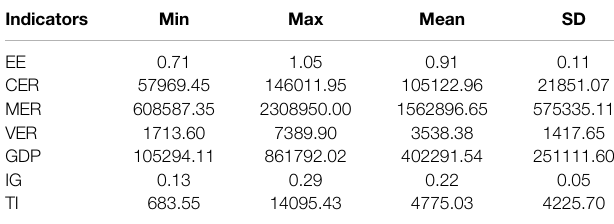
TABLE 2 | Descriptive statistics and variable